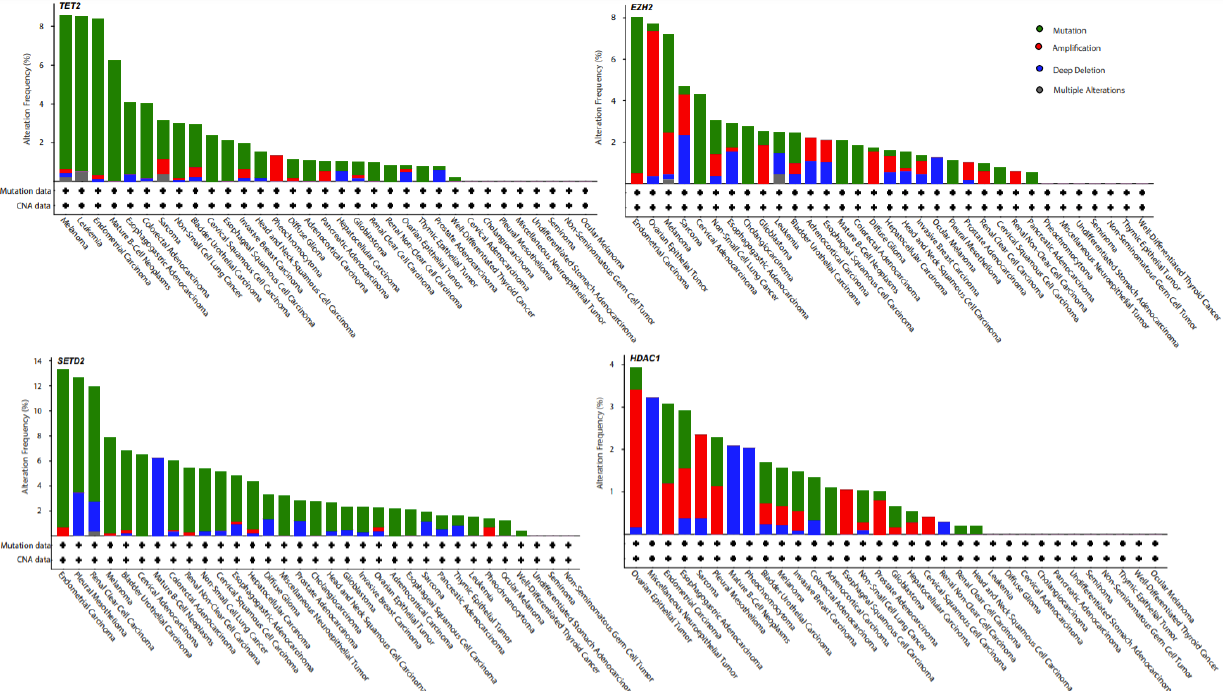
Figure 1. Genetic alteration in epigenetic regulating genes across various tumor types. TCGA Pan cancer data from 32 studies were analyzed on cBioPortal for Cancer Genomics. The bars represent the genetic alteration (mutations, amplifications, deep deletions, etc.) frequencies of TET2 , SETD2 , EZH2 and HDAC1 across different cancers. The analysis was performed as detailed previously [42,43].